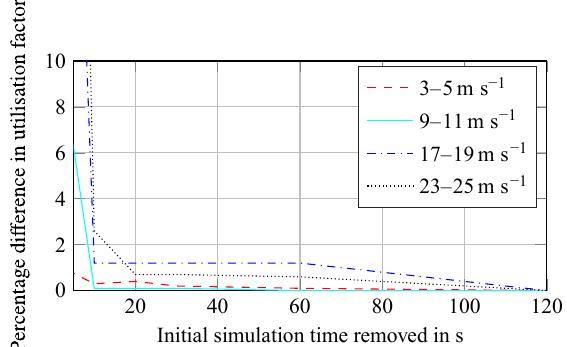
Figure 16. Initial transient behaviour of the wind turbine with a monopile substructure for different wind speeds. Percentage differ- ence in the utilisation factor (ULS) compared to the “converged” value (120s).